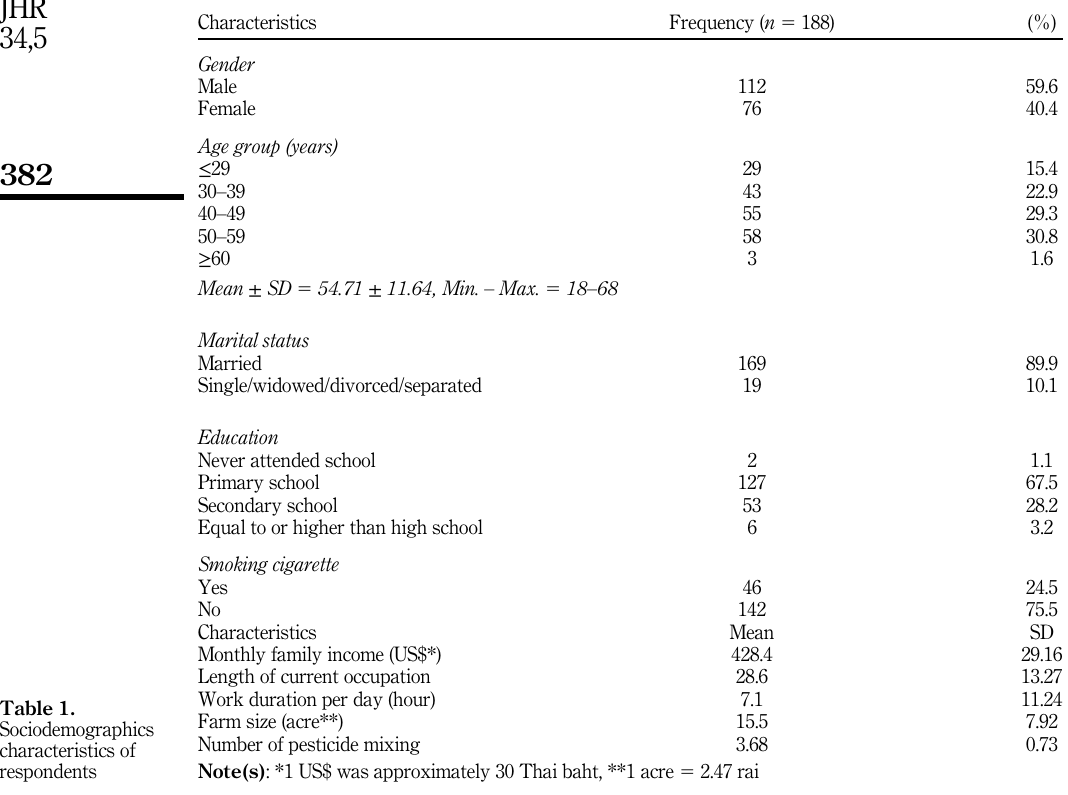
Table 1. Sociodemographics characteristics of respondents